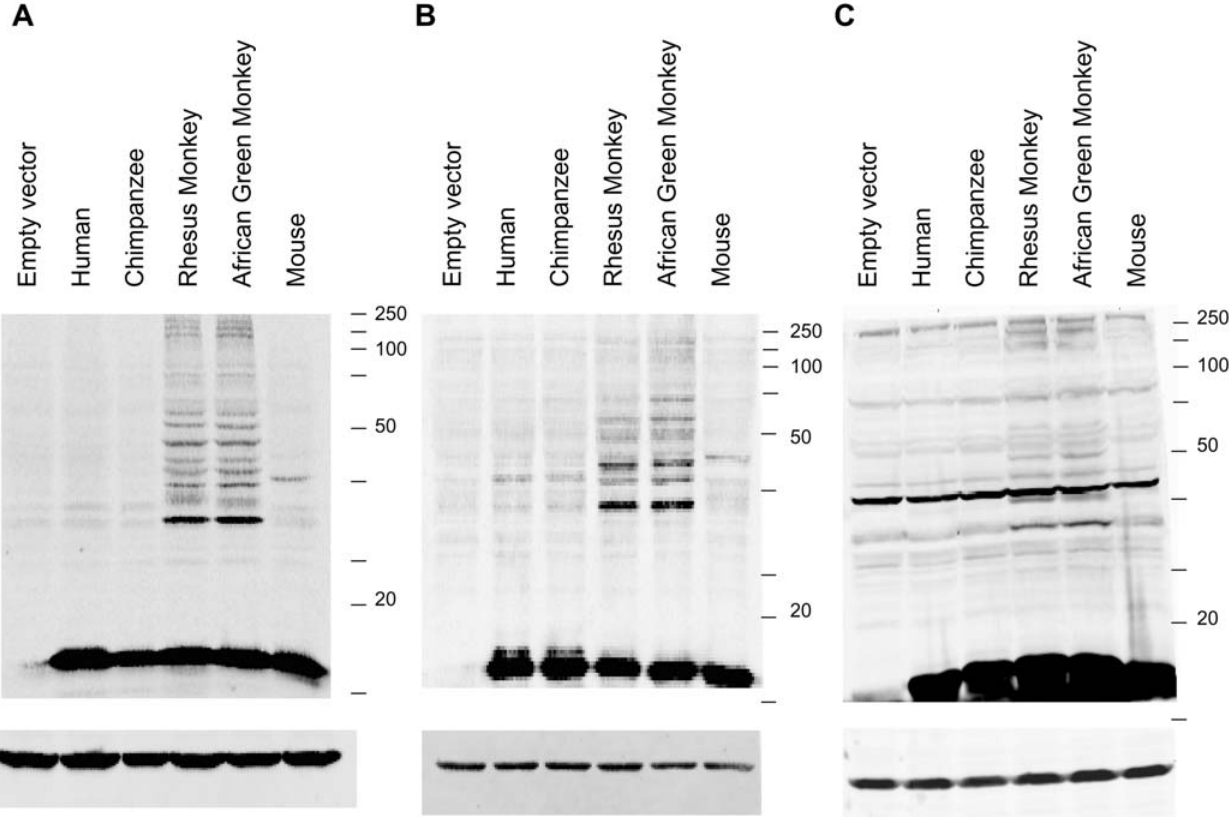
Figure 2. OWmISG15s conjugate more efficiently to target proteins. ISGylation pattern of FLAG-tagged Human, Chimpanzee, Rhesus Monkey, African Green Monkey and Mouse ISG15 in (A) human HekT cells, (B) monkey COS cells and (C) mouse N38 cells. Cells were only transfected with expression vectors for the indicated ISG15 orthologues, without extra stimulation. Upper panels : Western blot analysis on total cell lysates showing the total ISGylation pattern after ectopic expression of the indicated ISG15 orthologues as visualized by their FLAG-tag (anti-FLAG Ab). Lower panels : actin loading control (anti-actin Ab). doi:10.1371/journal.pone.0002427.g002 PLoS ONE |